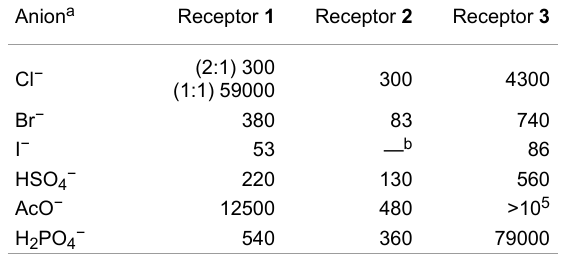
Table 1: Stability constants ( K a ) determined by 1 H NMR in acetone- d 6 solution at 298 K for receptors 1 – 3 with a variety of anionic guests. Anion